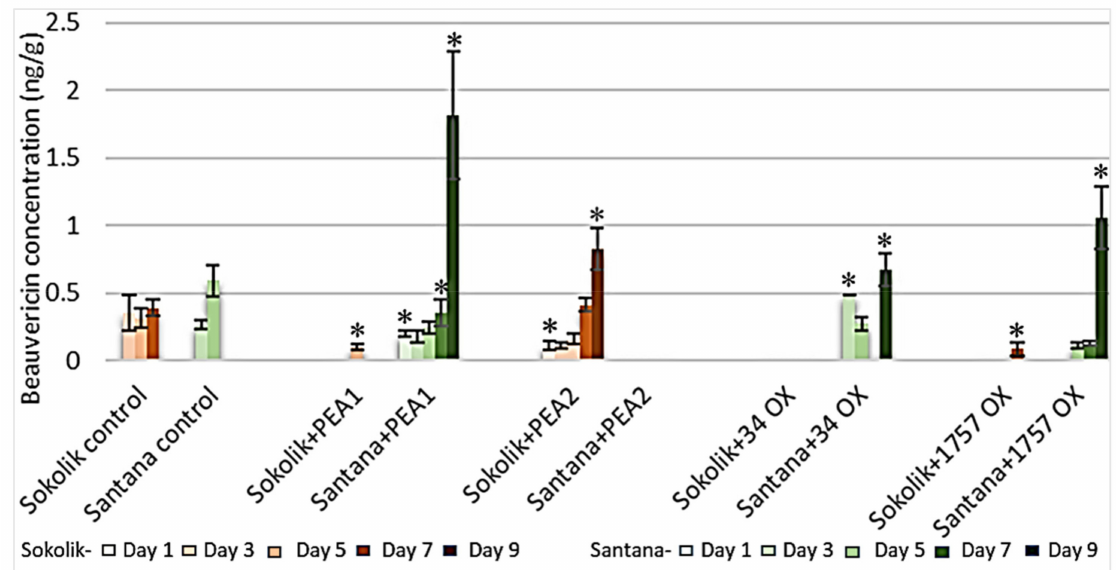
Figure 10. Concentration of beauvericin (ng/g) in Sokolik and Santana roots upon infection with PEA1, PEA2, 34OX and 1757OX calculated from triplicate treatments. Error bar represents the standard error. * Statistically significant ( p <